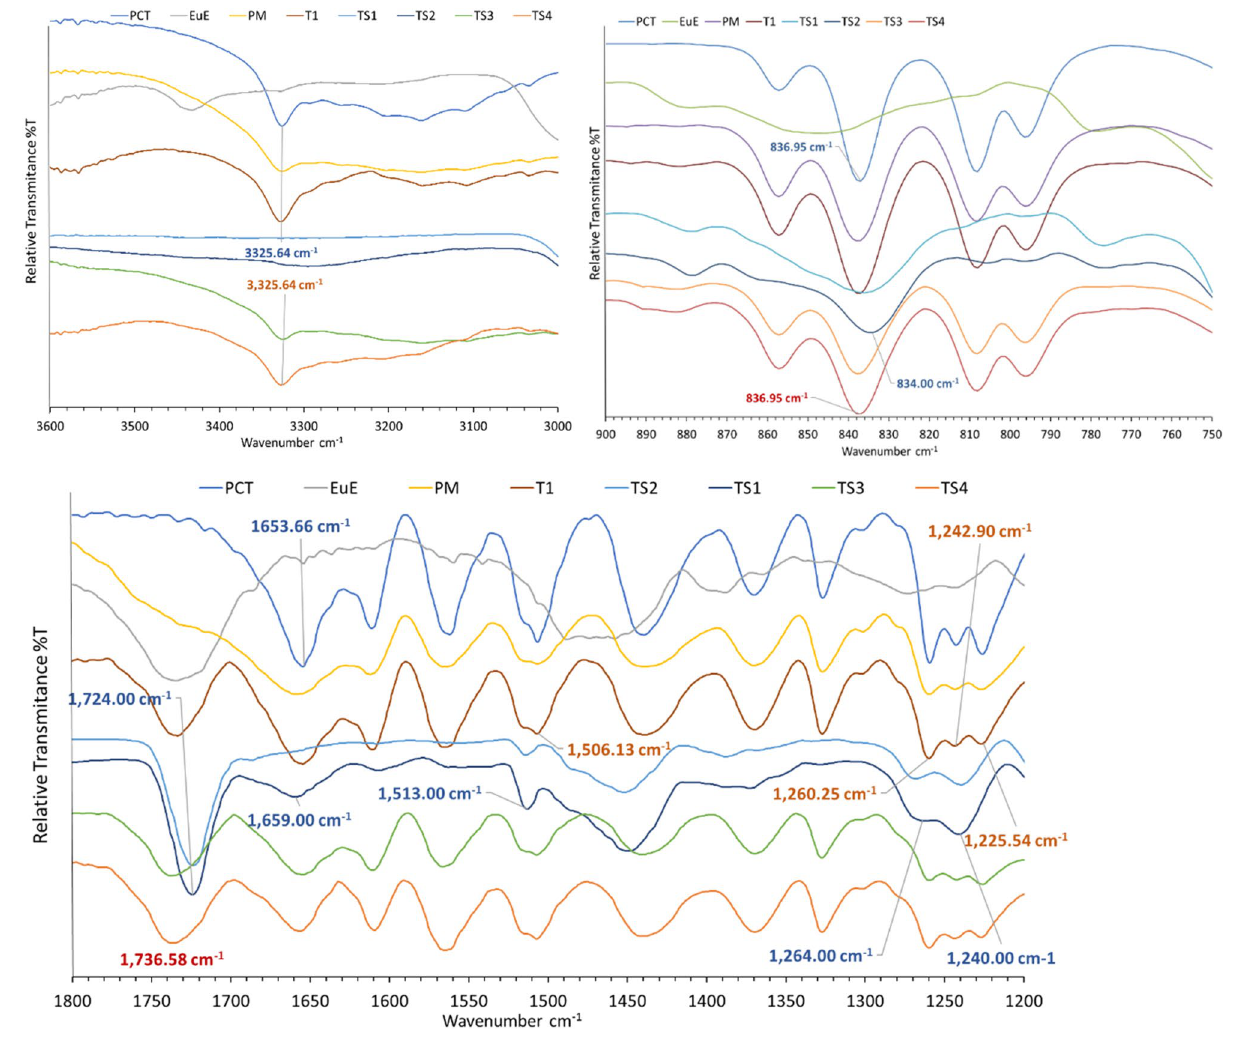
Figure 5. IR spectra of PCT, EuE, 1:1 PM, T1, and TS